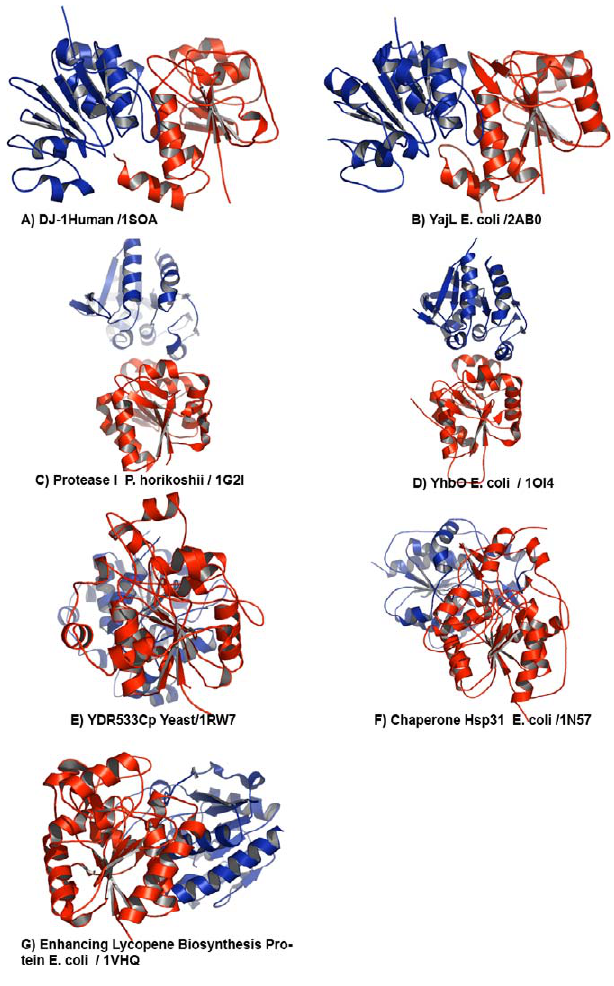
Figure 1. Dimer Structures for Seven DJ-1 Family Members with the Two Subunits Shown in Red and Blue (A) Human DJ-1; (B) YajL from E. coli; (C) Protease I from P. horikoshii; (D) YhbO from E. coli; (E) YDR533Cp from yeast; (F) Chaperone Hsp31 from E. coli; (G) the structural genomics putative Enhancing lycopene biosyn- thesis protein from E. coli . For all structures, the red subunits are